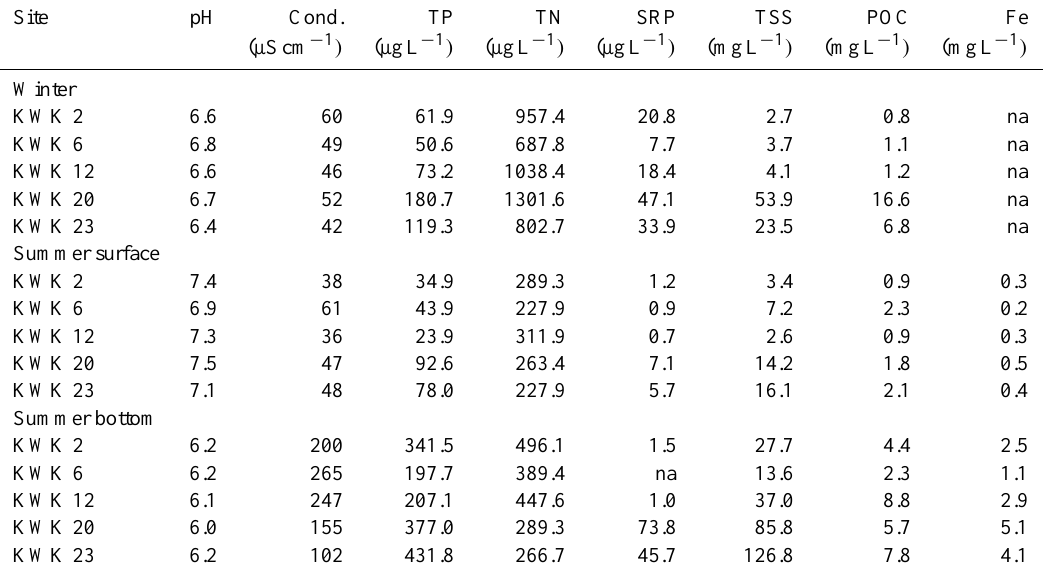
Table 1. Limnological properties of the subarctic ponds sampled in late winter and during summer at the surface and bottom of the water column, including pH, conductivity (Cond.), total phosphorus (TP), total nitrogen (TN), soluble reactive phosphorus (SRP), total suspended solids (TSS), particulate organic carbon (POC) and dissolved iron